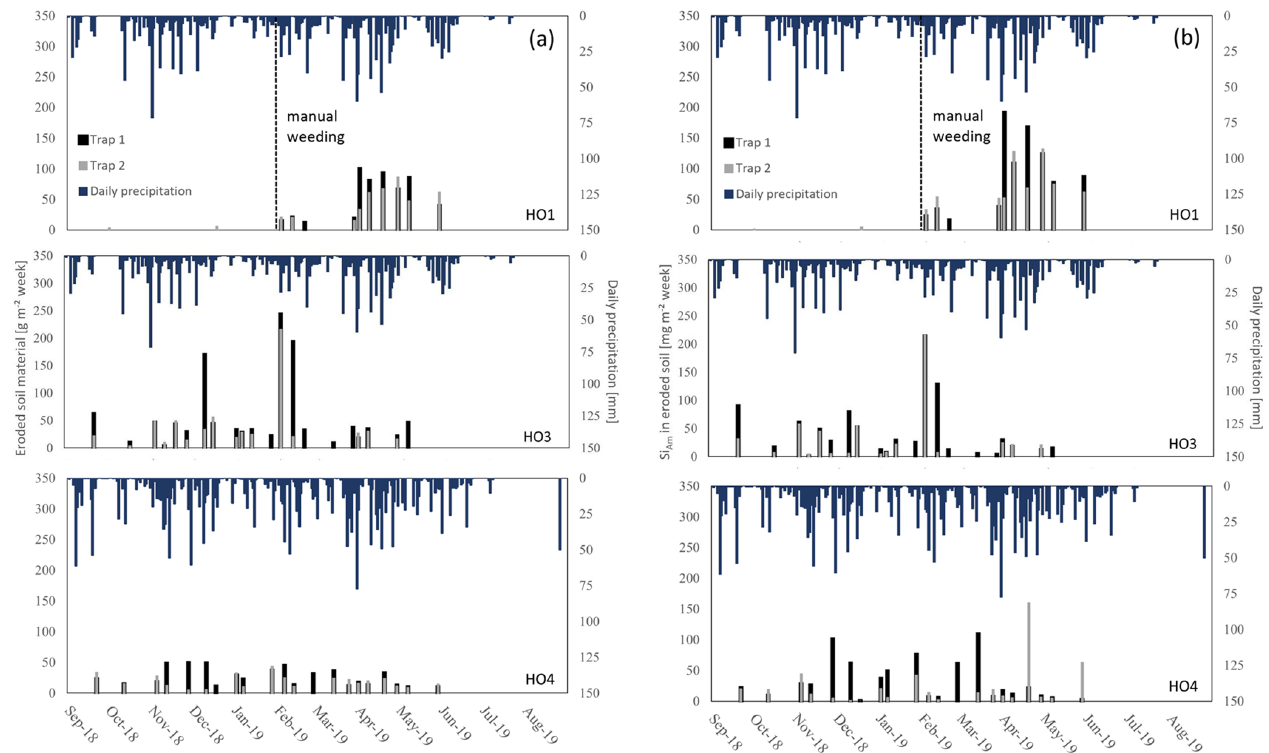
Figure 3. (a) Weekly losses of topsoil and (b) Si in amorphous silica (Si Am ) in eroded topsoil, collected from sediment traps ( n = 6) of oil-palm plantations in well-drained